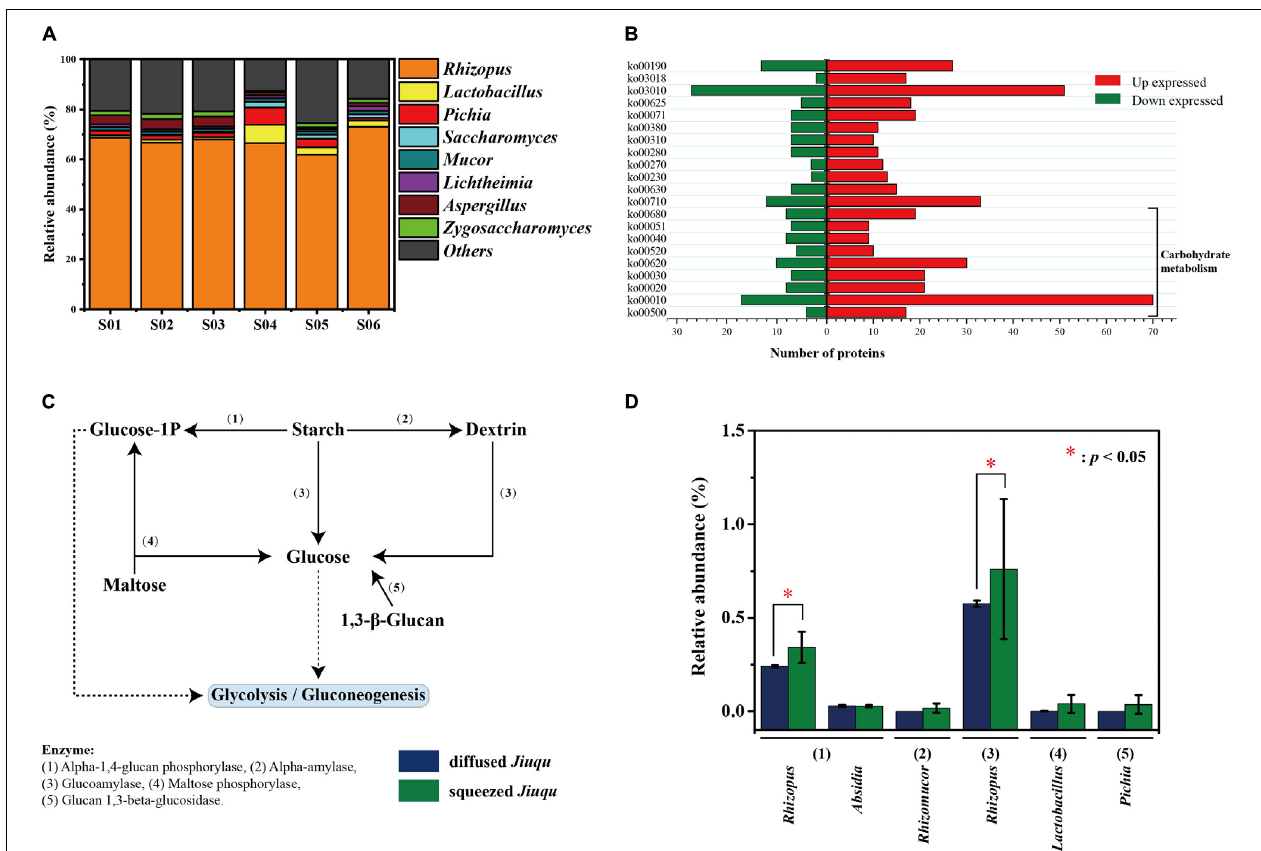
FIGURE 3 | Enzymatic profiles of diffused and squeezed Jiuqu . (A) Taxonomy distribution of diffused and squeezed Jiuqu ( n = 6, each bar n = 3). (B) The number of significantly different expressed proteins between diffused and squeezed Jiuqu by KEGG annotation. (C) The dominant saccharifying process in Jiuqu starter. (D) The core enzymes and microbiota related to the saccharifying process in Jiuqu starter. Compared to diffused Jiuqu , red asterisks denote statistically significant increase in squeezed Jiuqu (paired-sample t -test: ∗ , p < 0.05; ∗∗ , p < 0.01; ∗∗∗ , p < 0.001).